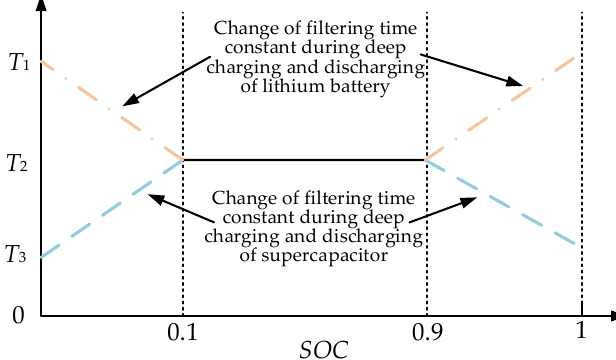
SOC . Figure 7. Adaptive adjustment of filtering time constant for improving SOC Sc . Sc